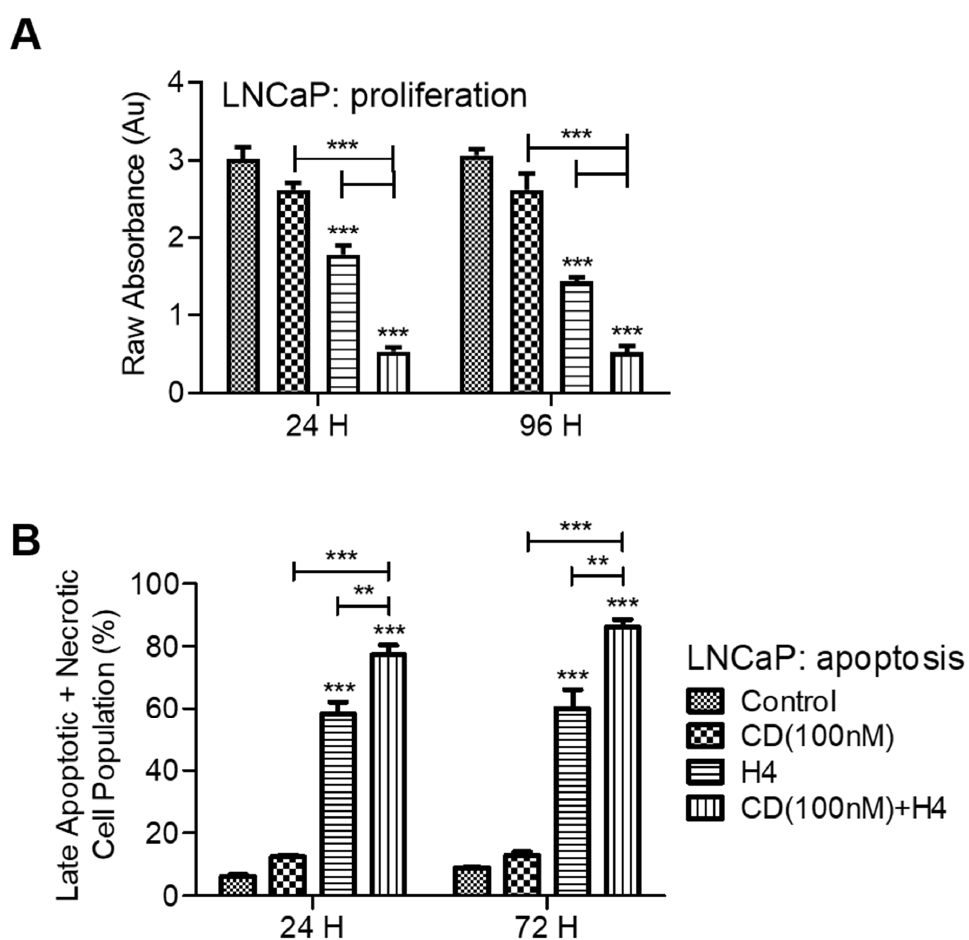
Figure 1. Combination effect of FUS and CDDO-me on proliferation and apoptosis in LNCaP cells. In ( A ), cell proliferation (WST-8 assay) at 24 h and 96 h post treatment with CDDO-me (100 nM) + FUS (H4) is shown. In ( B ), the percentage of late apoptotic and necrotic cells at 24 h and 72 h post treatment with CDDO-me and FUS is shown. Bar graphs show ± SEM of 3–4 independent experiments. Significant differences from untreated controls or individual treatment groups